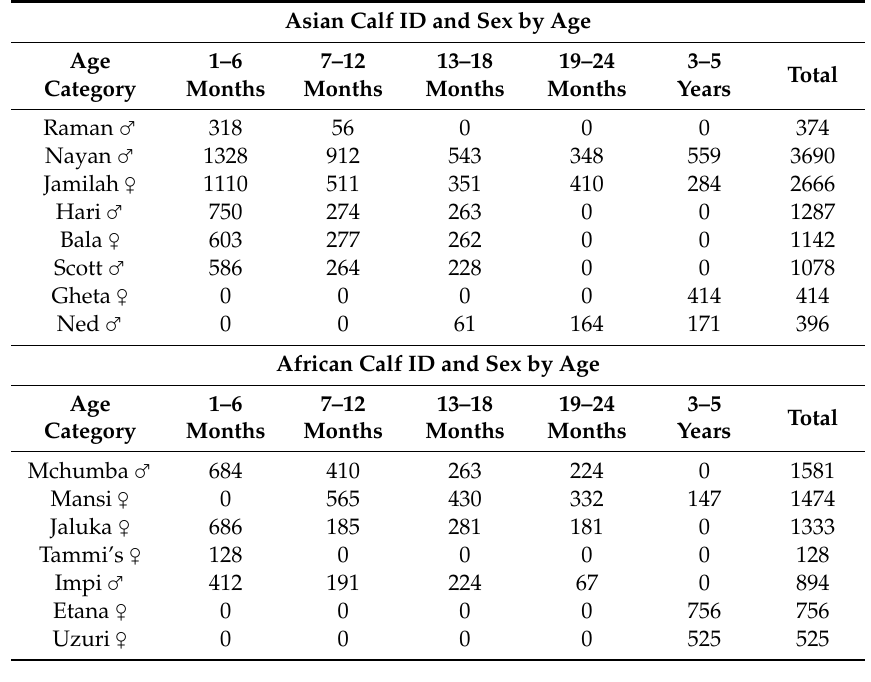
Table 4. Number of 5 min interval scans from all-day focal samples for individual captive calf at each age from birth (from 25 min scans for the older African and Asian